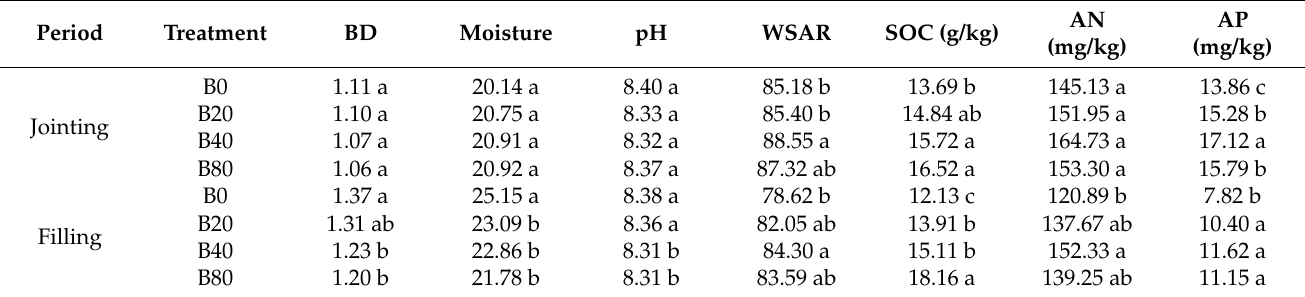
Table 2. Effects of biochar addition on soil physico-chemical characteristics.